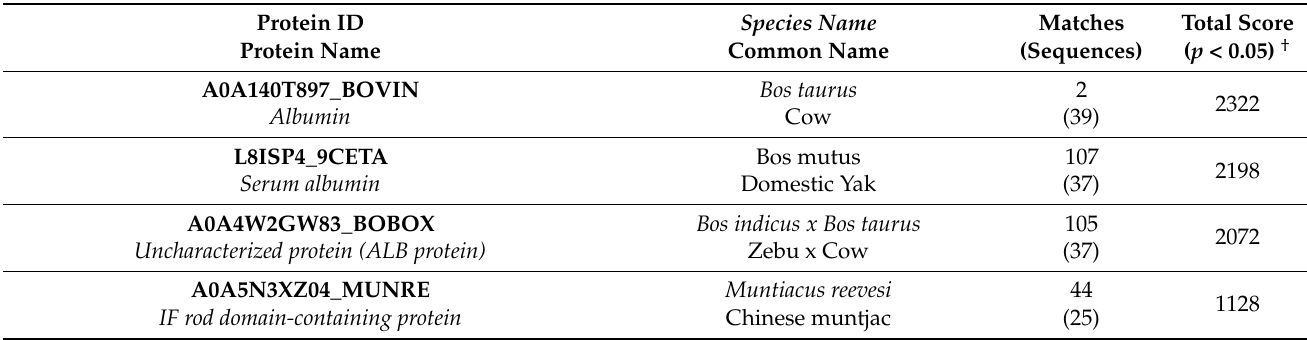
Table 1. Deiminated proteins in plasma EVs of reindeer ( R. tarandus ), identified by F95 enrichment and liquid chromatog- raphy with tandem mass spectrometry (LC–MS/MS) analysis. Proteins identified only in plasma EVs (and not in whole plasma) are highlighted in blue and with an asterix (*); uncharacterized hits with a secondary hit that was annotated are included and indicated in brackets. Protein ID, protein name, species hit with the Artiodactyla UniProt database, number of matches and total score are included in the table. For full detailed LC–MS/MS data for F95-enriched proteins, see Supplementary Table